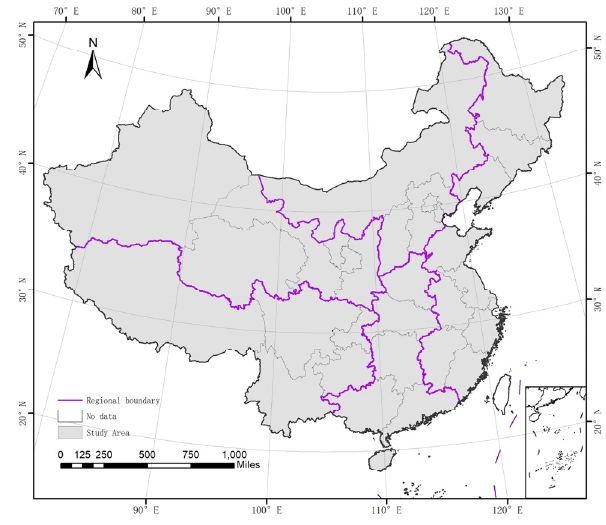
Figure 1. Study area.